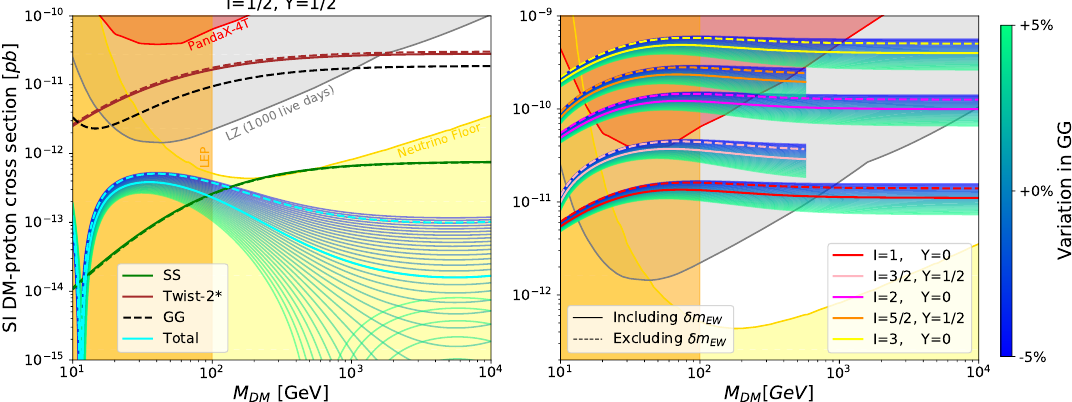
Figure 8. Impact of mass splits on the one-loop cross sections for pseudo-Dirac multiplet. On the left, we show the contribution of various operators with and without mass splits, and the impact on the total. The variation is due to a 5% variation in the GG contribution. On the right we show the total contribution with variation for other multiplets with larger isospin, I ≥ 1